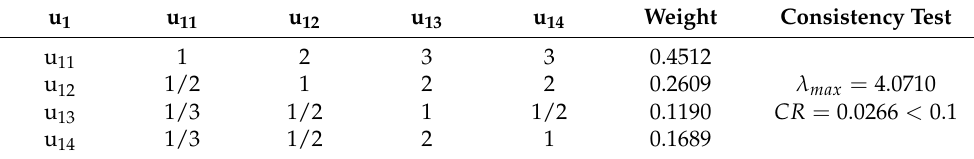
Table 8. The judgment matrix and weights of evaluation indicators under u 1 .